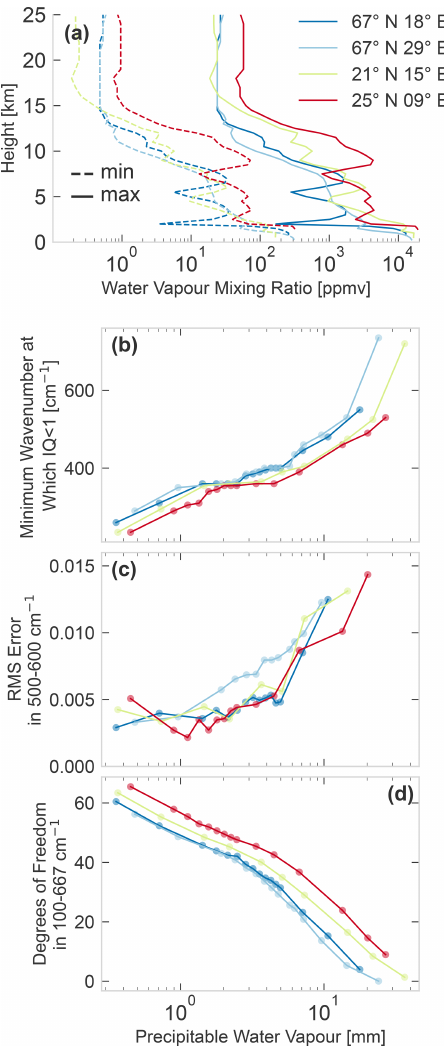
Figure 6. Retrieval quantifiers as a function of scene precipitable water vapour. For each scene, the climatological water vapour pro- file was multiplied by a constant factor when generating the syn- thetic observations so as to keep everything constant, except for the water vapour content. Panel (a) shows the minimum (dashed line) and maximum (full line) modified water vapour profile. Pan- els (b) , (c) and (d) have a shared x axis showing the precipitable water vapour of each scene, with the colour coding of the lines and markers the same as in panel (a) . Panel (b) shows the min- imum wavenumber at which the retrieved emissivity satisfies the criterion in Eq. (8). Panel (c) shows the root mean square (RMS) error of the retrieved true emissivity in the 500–600cm − 1 range for the cases with full sensitivity in that range (thus, even for this con- servative range, the RMS is not calculated for the highest pwv val- ues). Panel (d) shows the degrees of freedom in the 100–667cm − 1 range (the sum of the emissivity averaging kernel submatrix rows corresponding to that range). All three figures show the quantifiers improve as the water vapour content